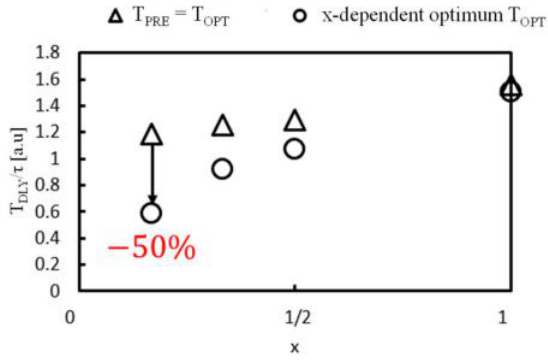
Figure 11. T DLY vs. x under the worst corner.